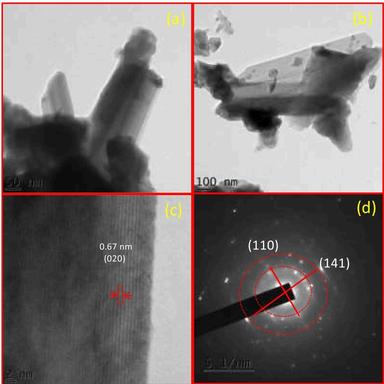
(a-b) TEM images, (c) HRTEM image, and (d) SAED pattern of as-prepared MoO3 (1:1) nanoparticles.